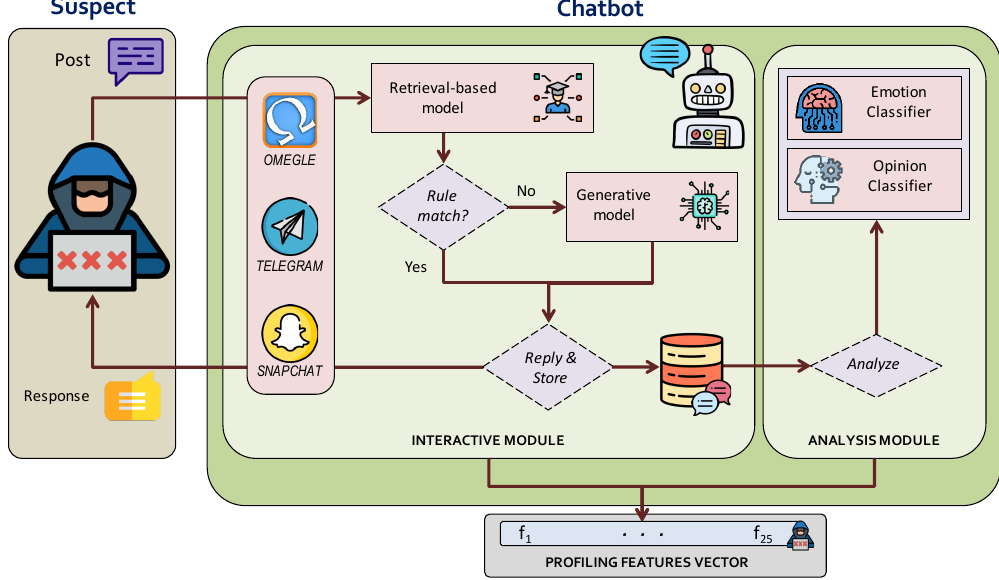
Figure 2. C 3 -Sex overview depicting the workflow of posts and